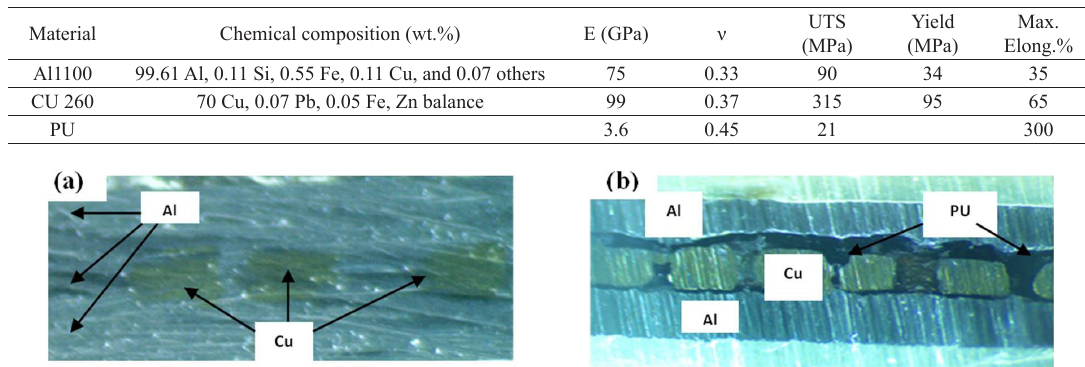
Table 2. Specification of Al1100, CU 260, and PU.